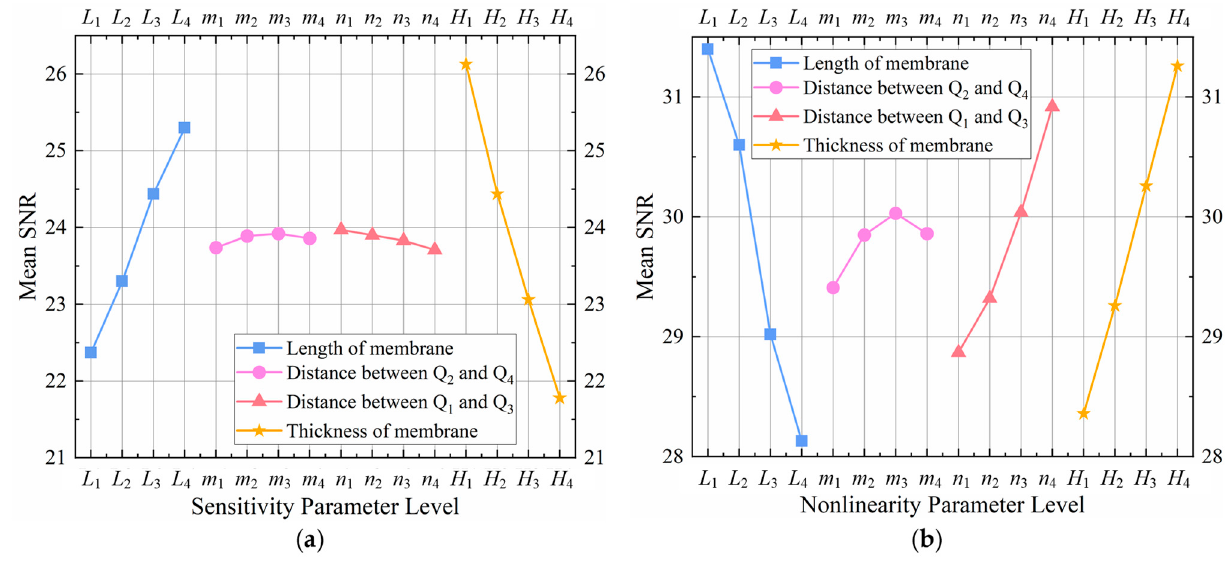
Figure 8. The mean SNR graphs for sensitivity and nonlinearity: ( a ) the larger-the-better SNR graph for sensitivity improvement; and ( b ) the smaller-the-better SNR graph for nonlinearity reduction.